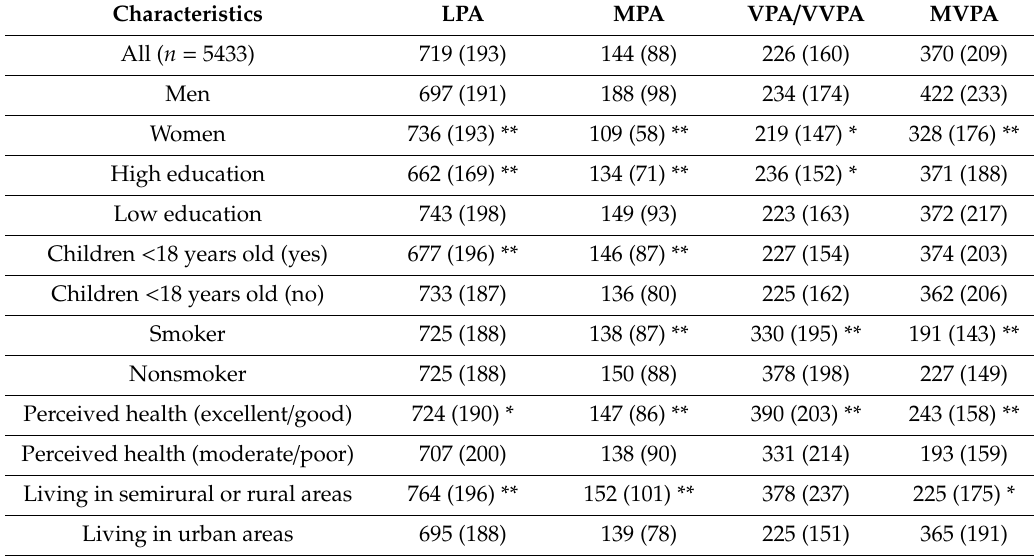
Table 2. Daily average MET-minutes (Metabolic Equivalent (SD)) of accelerometry measured PA according to socioeconomic, lifestyle habits, and residential